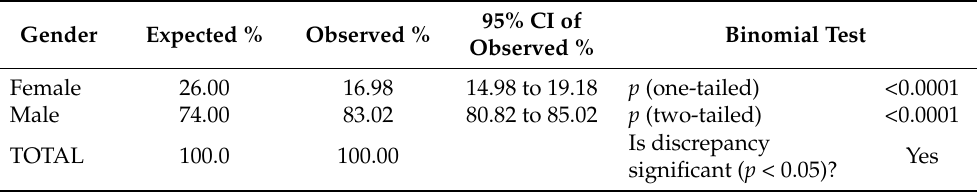
Figure 4. Graphical representation of the comparison of the composition of the combined data of national, regional, and provincial ANDI boards with that of the population practicing dentistry in Italy, represented, in terms of percentages, as 74% male and 26% female. Table 6. Binomial tests for the comparison of the composition of the combined data of national, regional, and provincial ANDI boards with that of the population practicing dentistry in Italy. The discrepancy resulted as statistically significant.